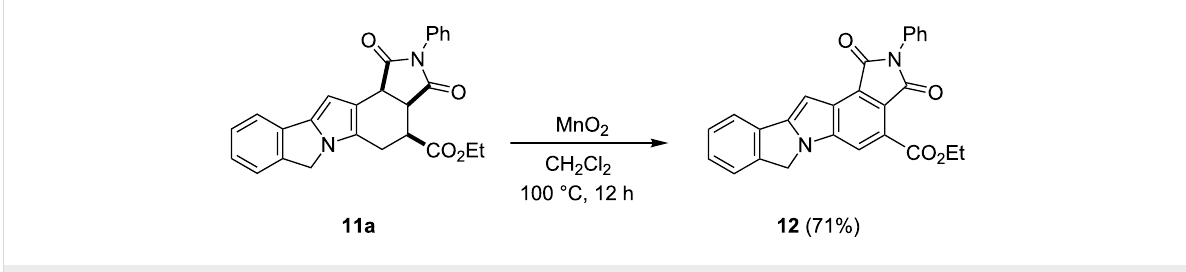
Scheme 7: Synthetic approach to the fused aza-heterocyclic pentacycle 12 .